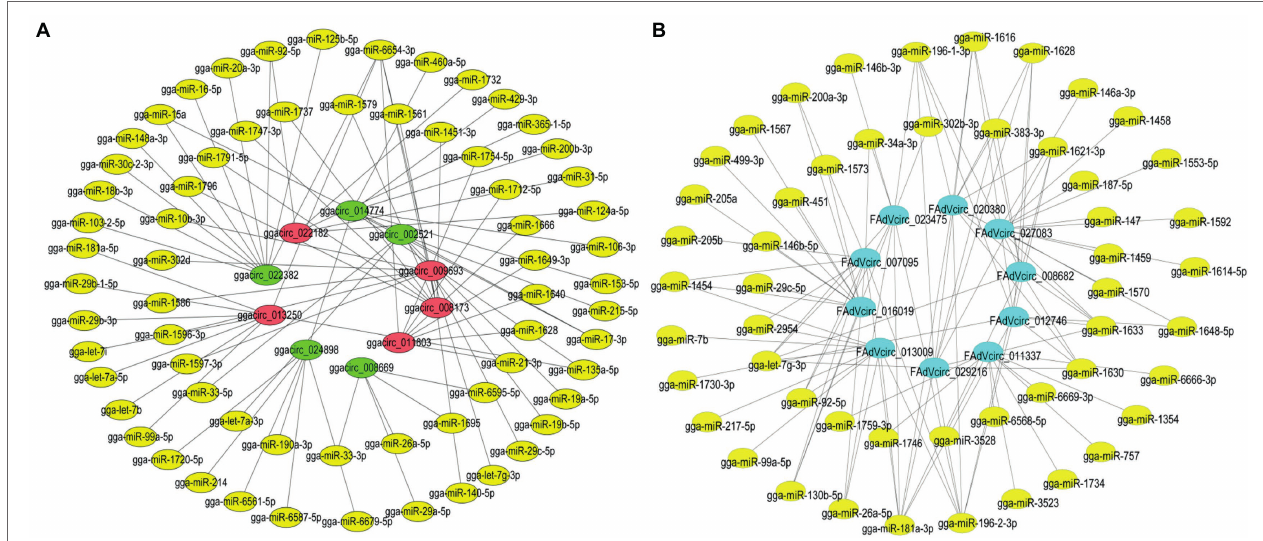
FIGURE 9 | The interaction network of circRNA-miRNA. (A) The interaction network of the 10 DE ggacircRNAs and their target miRNAs. The red oval represents upregulated circRNA, the green oval represents downregulated circRNA, and the yellow oval represents miRNA. (B) The circRNA-miRNA interaction network of 10 predicted and verified FAdVcircRNA. The bule oval represents circRNA, and the yellow oval represents